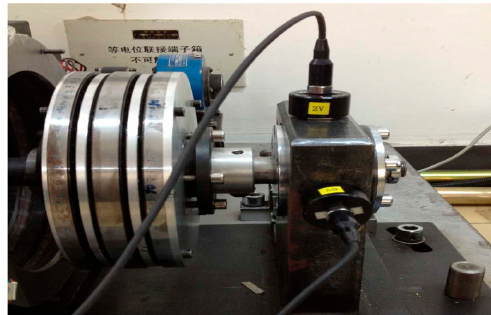
Figure 6. Experimental system and installation locations of the acceleration sensors.